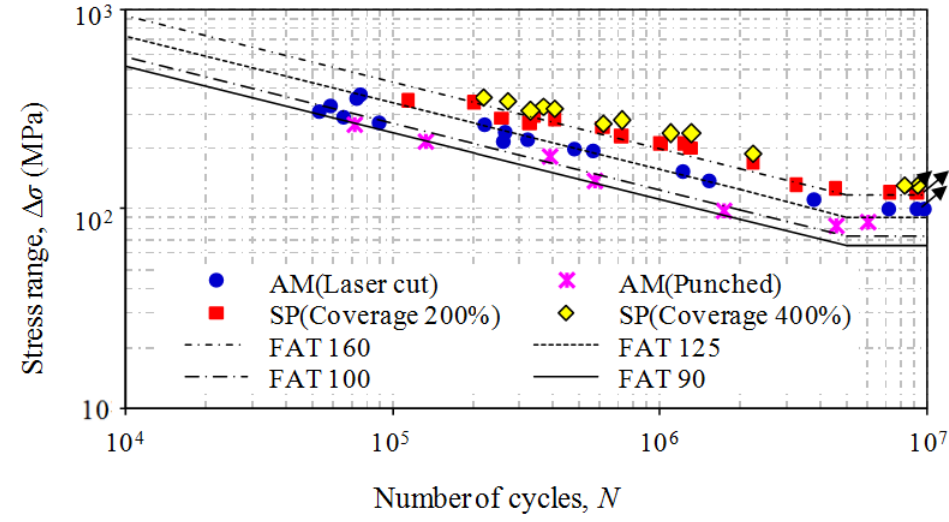
Figure 5. Comparison of S – N relations of shot-peened and bare steel open-hole details (AM: as-machined; SP: